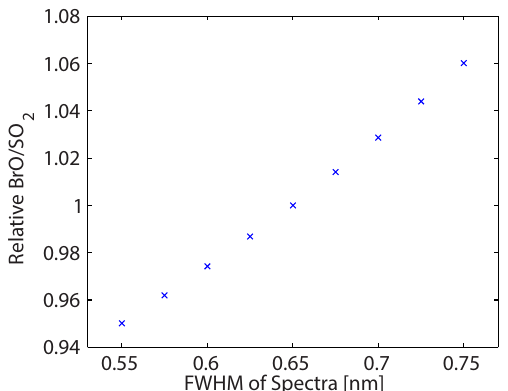
Figure 6. Deviation of the BrO / SO 2 ratio for varying synthetic spectra with different optical resolution. All spectra were evaluated using absorption cross sections that were convolved with a Gaussian profile with a FWHM of 0.65nm.